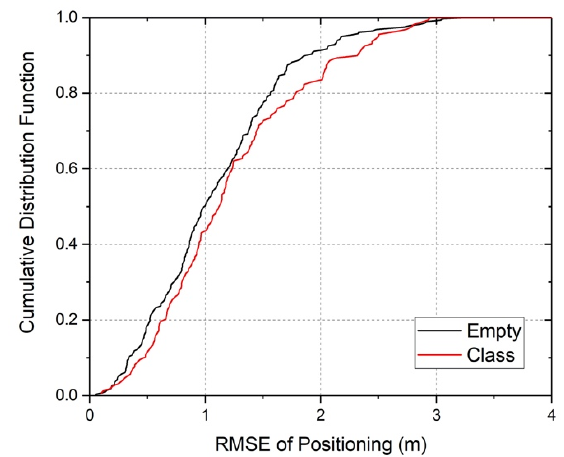
Figure 14. CDF comparison of classroom with / without Figure 14 . CDF comparison of classroom with/without students.